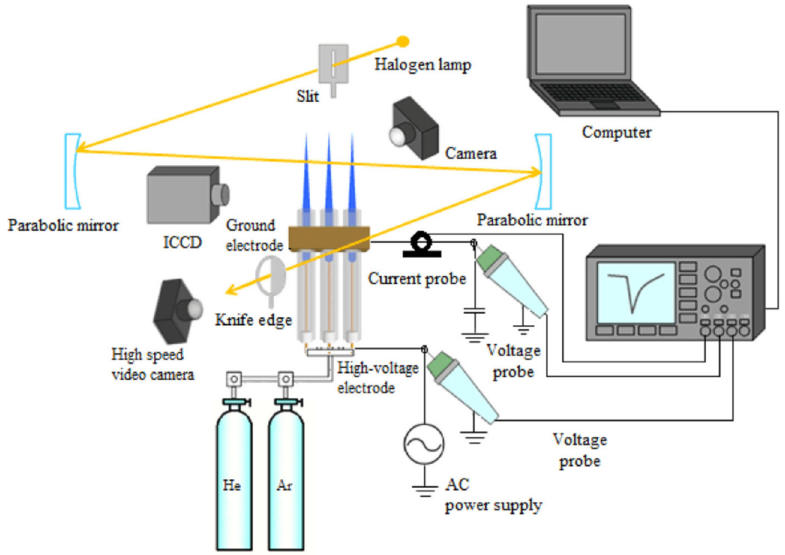
Figure 2. Scheme of an experimental setup prepared for the optical and electrical characterizations of multi-APPJs and associated gas streams. In this setup, both He and Ar APPJs were studied by measuring signal waveforms and obtaining Schlieren images of the plasma plume fluid dynamics. Reprinted/adapted with permission from Ref. [20]. Copyright 2017, WILEY-VCH Verlag GmbH & Co.